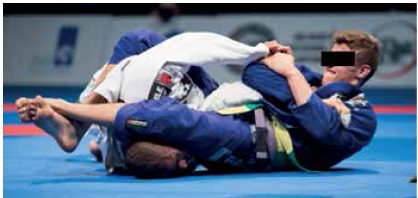
Armbar-type armlock.